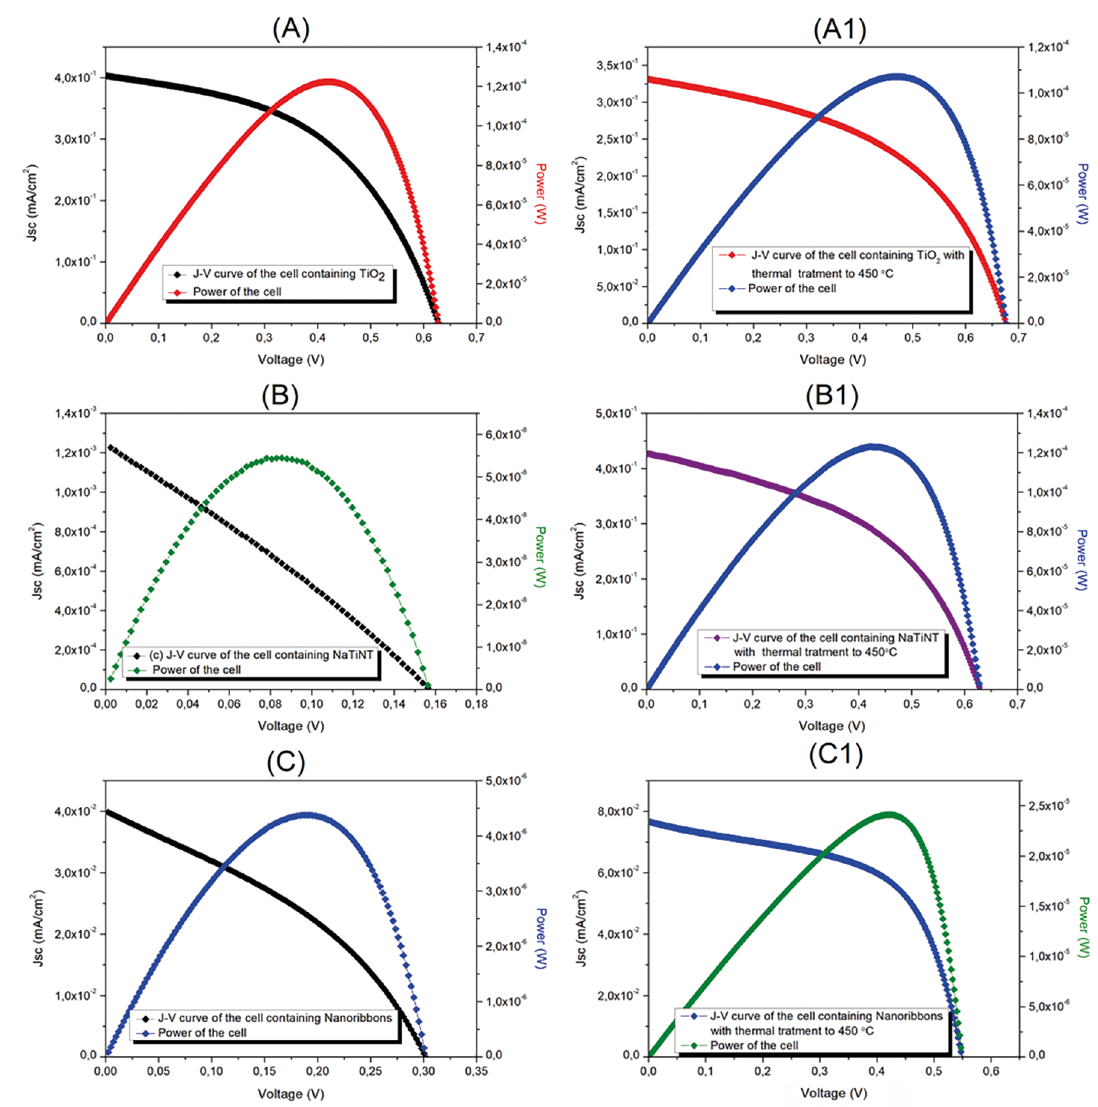
; (A1) TiO -450 °C; (B) NaTiNT; (B1) NaTiNT-450 °C; (C) Nanoribbons and (C1) Nanoribbons-450 °C. 2 2